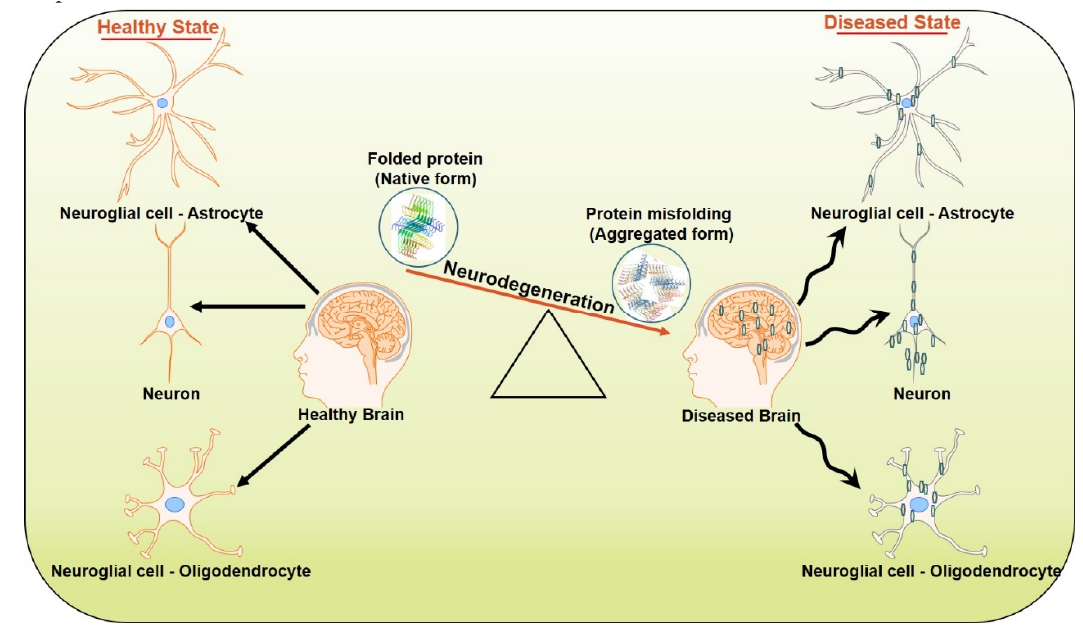
Figure 1. Progression of neurodegenerative diseases.